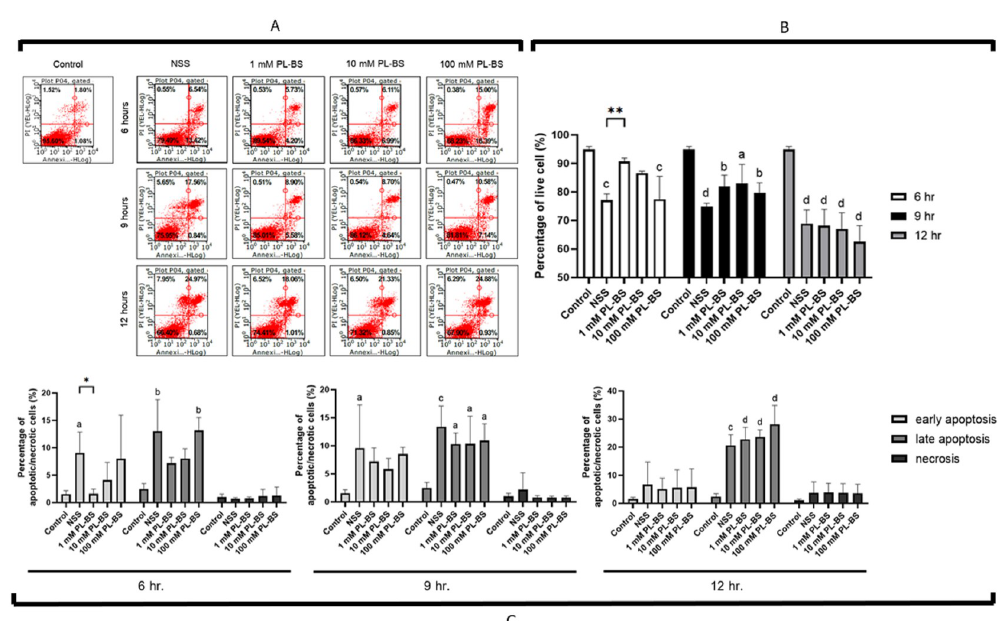
Fig 3. The effect of a hypothermic solution on cell viability and apoptotic/necrotic fraction. (A) The cAD-MSCs were stored in hypothermic solutions at concentrations of 1, 10, and 100 mM PL-BS or NSS for up to 6, 9, and 12 hours. (B) At 6 hours of hypothermic storage, the percentage of cAD-MSCs which had survived in 1 mM PL-BS was significantly higher than that in NSS (p < 0.01). (C) The level of early apoptotic cells at 6 hours of hypothermic storage in 1 mM PL-BS was significantly lower than that in NSS (p < 0.05). Remark symbols: Asterisk means values were significantly different from the NSS group; � = p < 0.05 and �� = p < 0.01. The lowercase letters a, b, c, and d above the bar indicate significant difference from the control group; a = p < 0.05, b = p < 0.01, c = p < 0.001, and d = p <